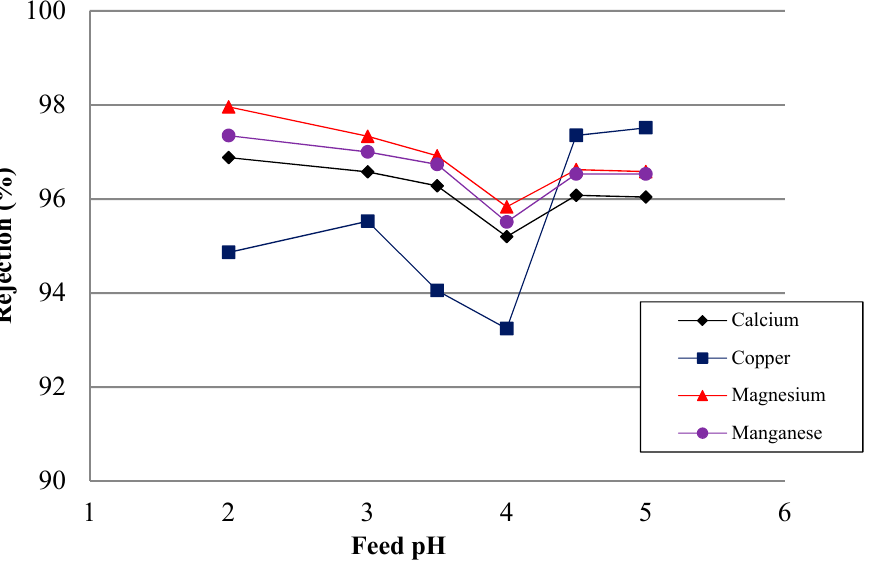
Figure 8. Apparent metal species rejection as a function of feed pH.